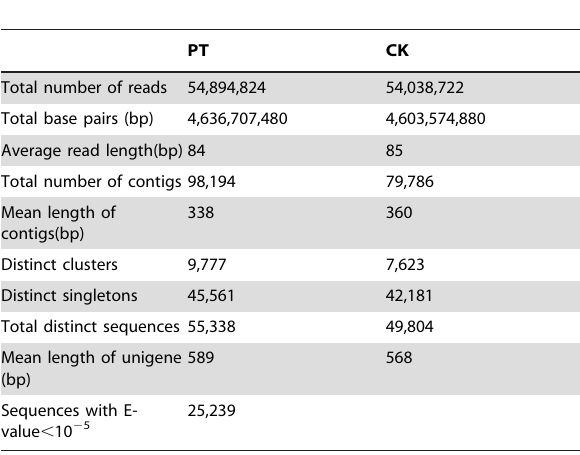
Table 2. Summary for the Chironomus kiiensis transcriptome in phenol treated (PT) and control (CK) libraries. Table 3. Length distribution of non-redundant consensus